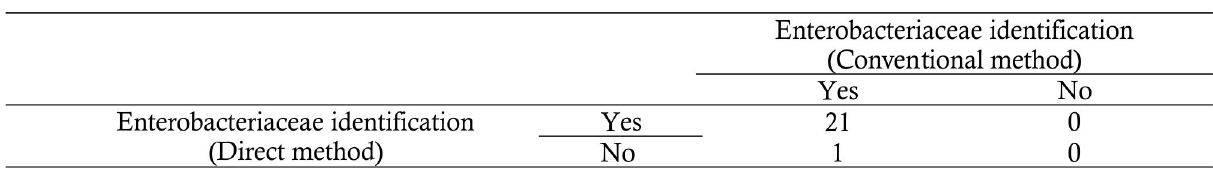
Table 2. Direct identification methods 2x2